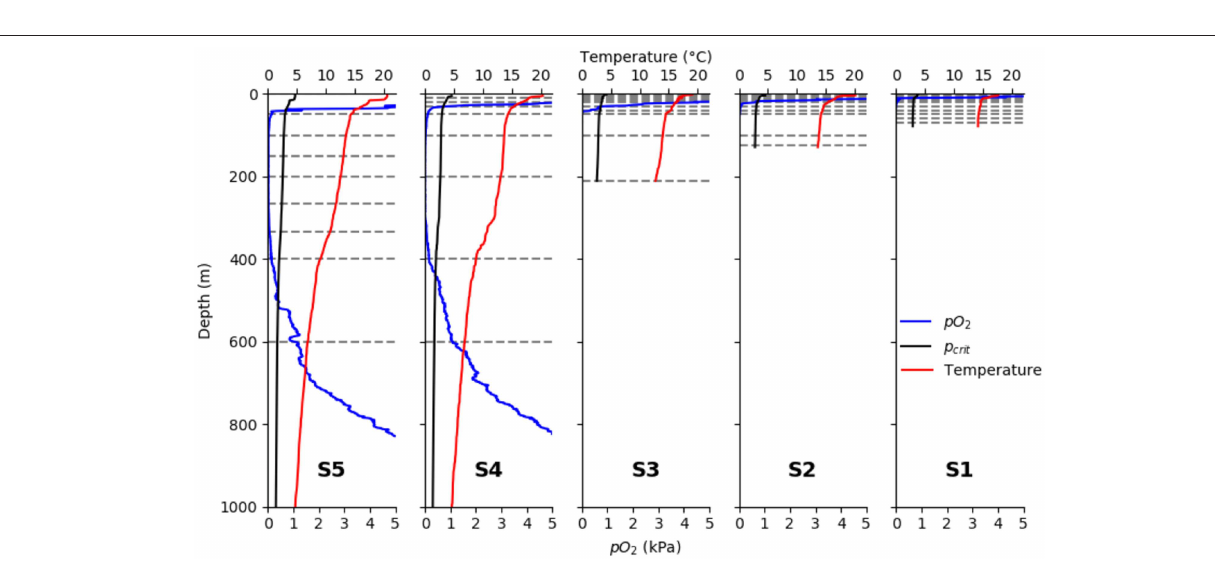
thermo- and oxycline depths decreased from shelf to